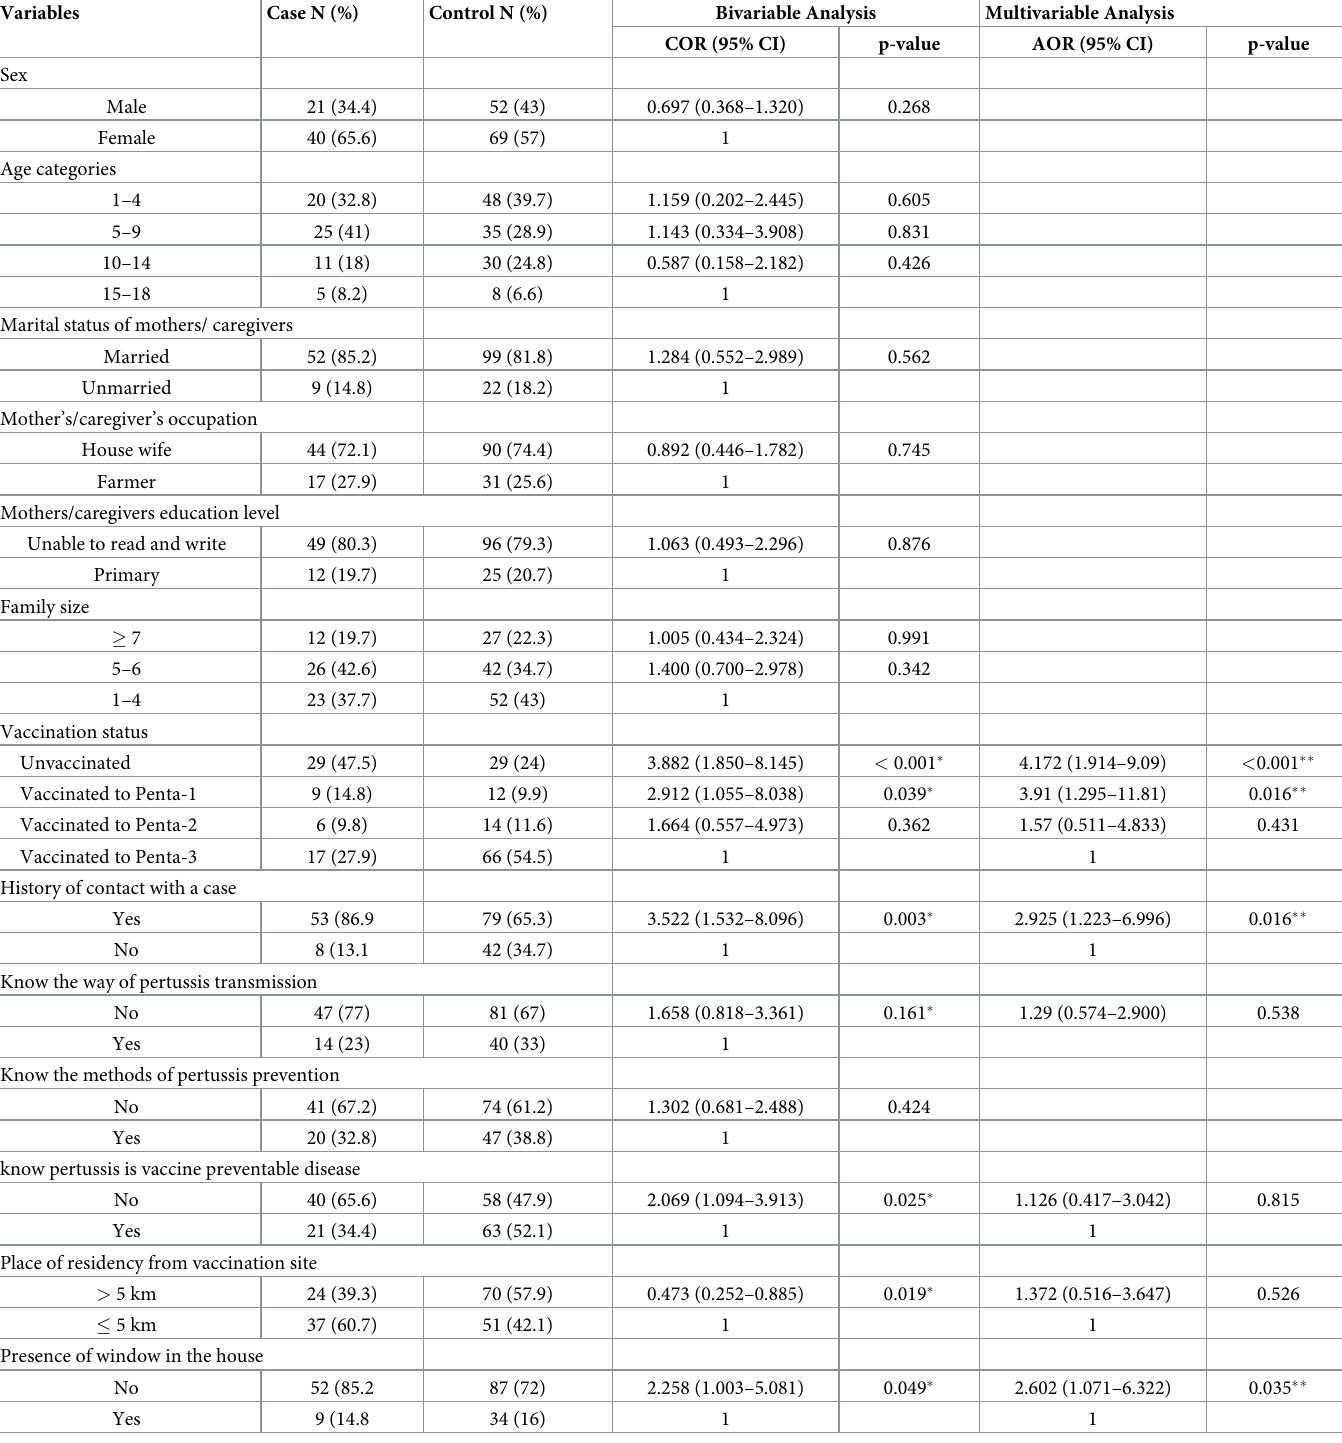
Table 4. Bivariable and multivariable logistic regression analysis of risk factor for pertussis infection in the Azila cluster of Dahena district,